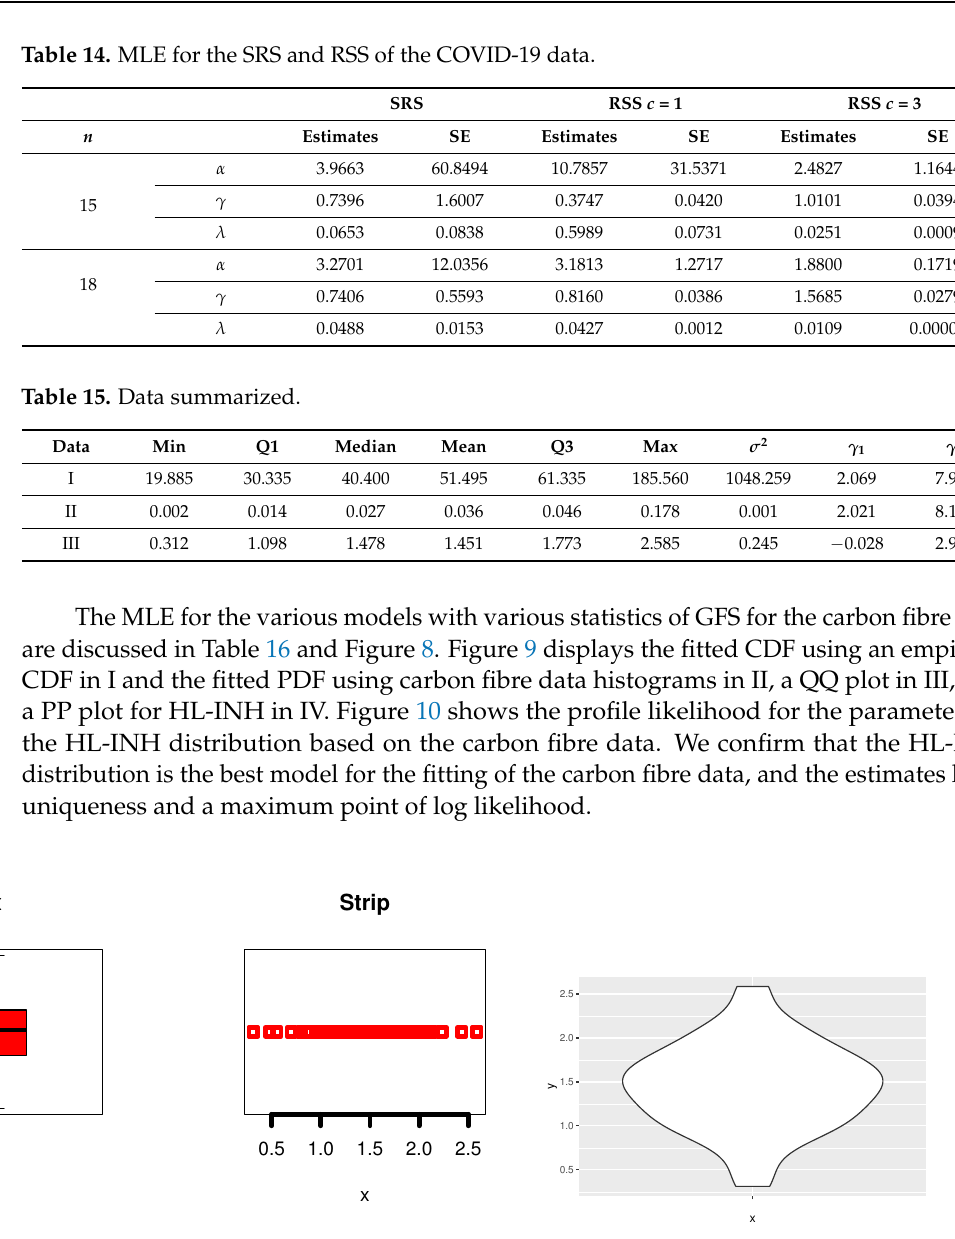
Figure 8. Data description for the carbon fibre data using box, strip, and violin